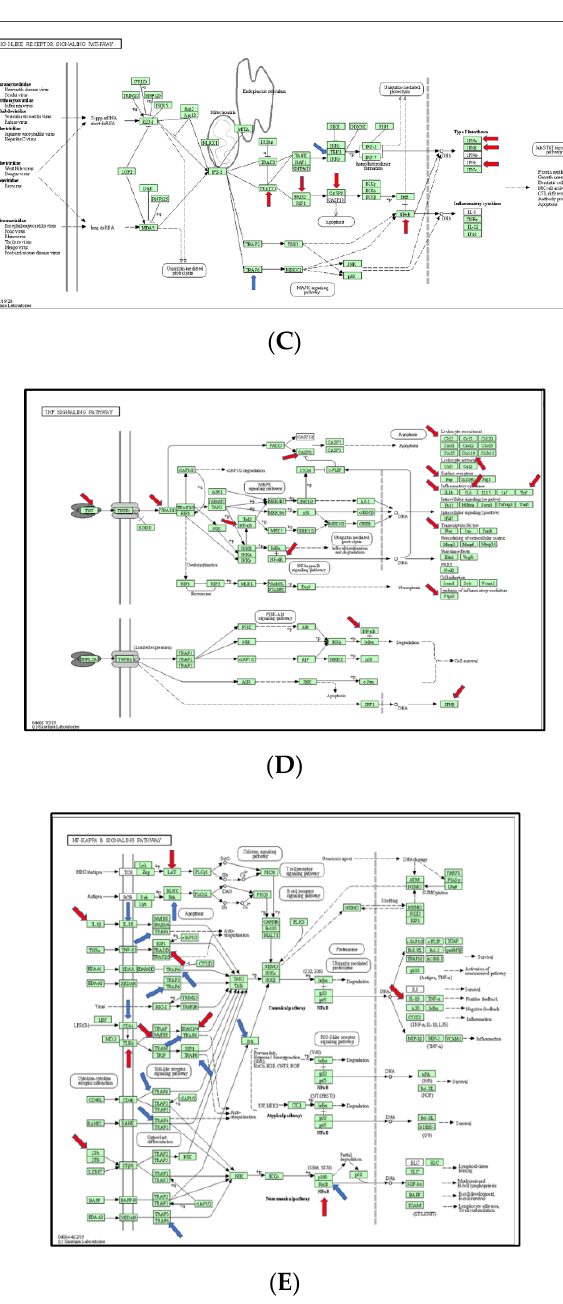
Figure 5. ( A ) Mapping of TLR-signaling pathway in burn injury rats. Each gene in the KEGG TLR- signaling network (KEGG rno04620) is colored according to its expression level in the burn injury group compared with that of the sham group. Genes that were significantly upregulated are colored red, and those that were significantly downregulated are marked blue; ( B ) Mapping of IL-17 signaling pathway in burn injury rats. Each gene in the KEGG TLR-signaling network (KEGG rno04657) is colored according to its expression level in the burn injury group compared with that of the sham group. Genes that were significantly upregulated are colored red, and those that were significantly downregulated are marked blue; ( C ) Mapping of RIG-I-Like receptor signaling pathway in burn injury rats. Each gene in the KEGG TLR-signaling network (KEGG rno04622) is colored according to its expression level in the burn injury group compared with that of the sham group. Genes that were significantly upregulated are colored red, and those that were significantly downregulated are marked blue; ( D ) Mapping of TNF signaling pathway in burn-injury-induced upregulated DEGs in rats. Each gene in the KEGG TNF signaling network (KEGG rno04668) is colored according to its expression level in the burn injury group compared with that of the sham group. Genes that were